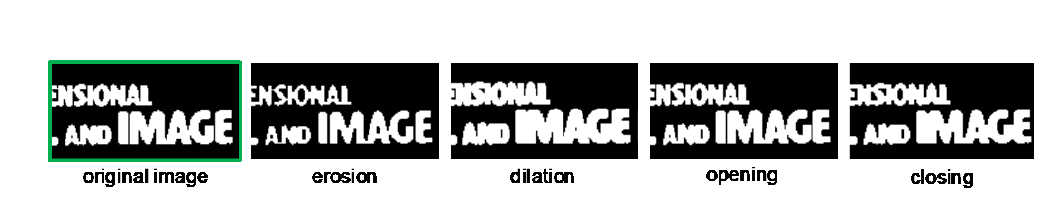
Figure 4. Demonstration of the morphological applications (Source: Wolfram)